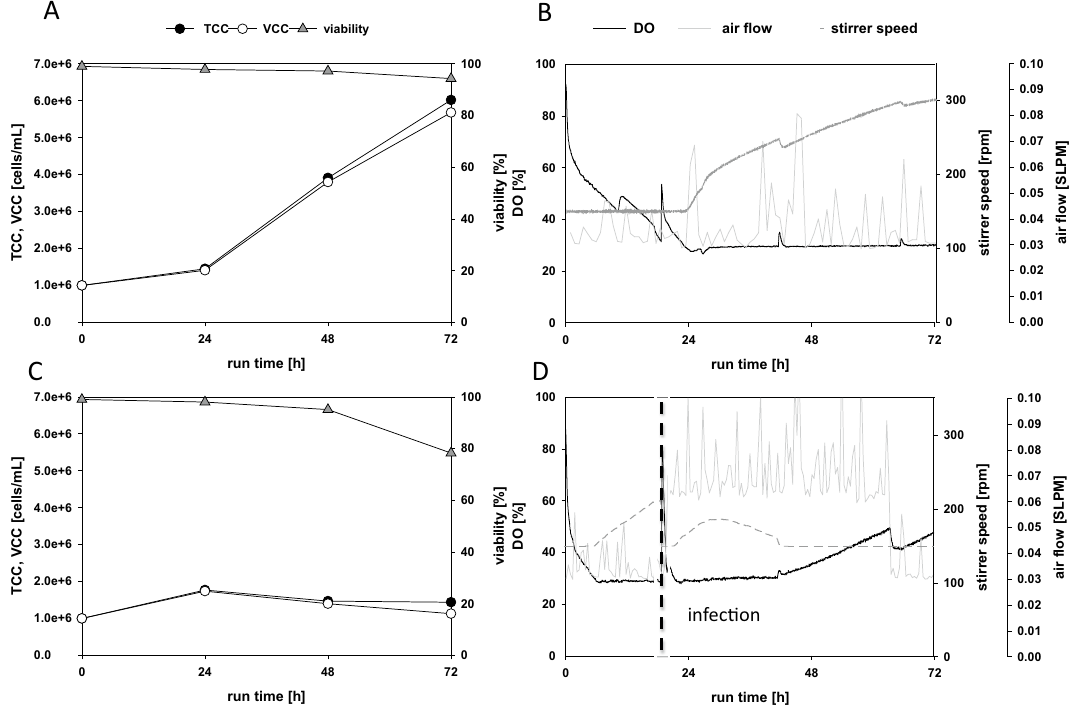
Figure 5. Testing a new control strategy on two cultivations of TN42 insect cells. The controller was tested on ( A , B ) an uninfected batch cultivation, and ( C , D ) an infected batch process. In both cases, the starting stirring speeds were 150 rpm, and the controller increased or decreased the speed to maintain the DO at 30%. ( A , C ) Counts of total (TCC, filled circles) and viable (VCC, open circles) cells, and cell viability (triangles) over the course of the batch cultivation. ( B , D ) Dissolved oxygen (DO, solid black line), air flow (solid grey line), and agitation speed (dotted line). The vertical line in Figure ( D ) indicates the time of